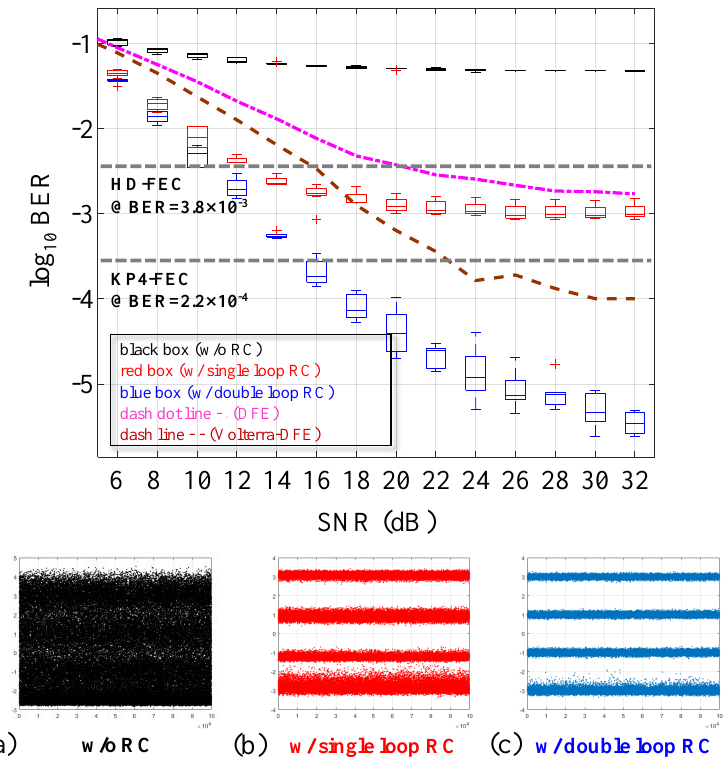
Figure 10. Transmission performance curve: ( a – c ) The time-domain scatter graph of PAM4 signals ( a ) corresponding to the case without RC; ( b ) corresponding to the case with the single-loop RC; ( c ) corresponding to the case with the proposed double-loop RC.